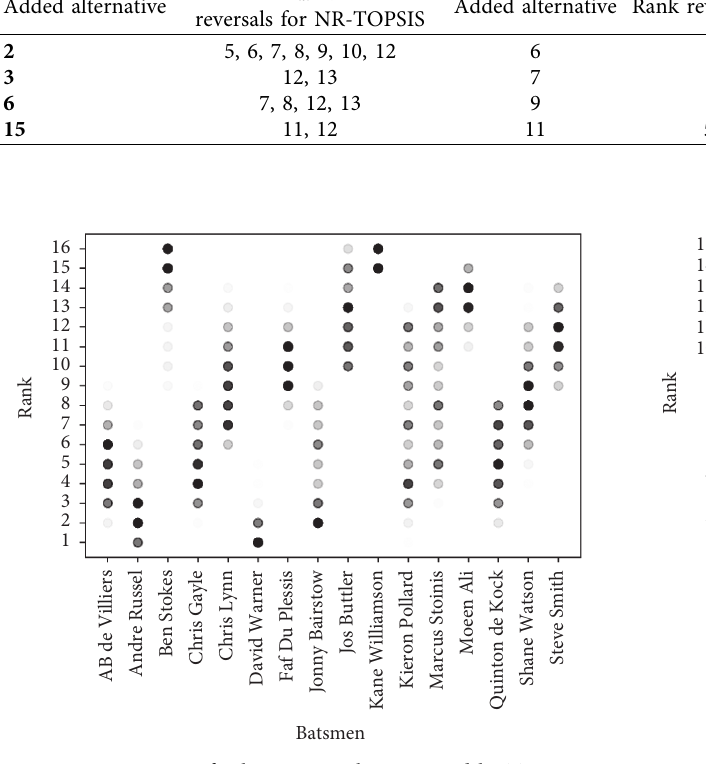
Figure 3: Heat map for batsmen ranks generated by TOPSIS. Figure 4: Heat map for bowler ranks generated by